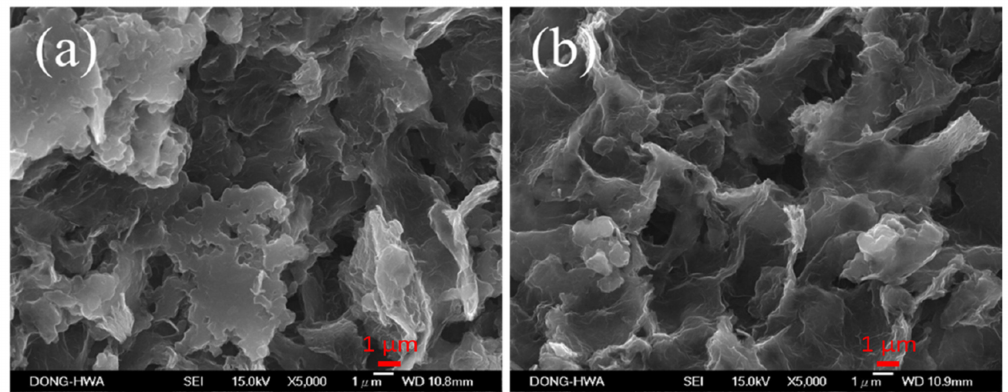
Figure 5. SEM images (5000 × ) of ( a ) as-deposited and ( b ) 100 ◦ C-annealed rGO / PANI nanocomposites on APPJ-modified graphite